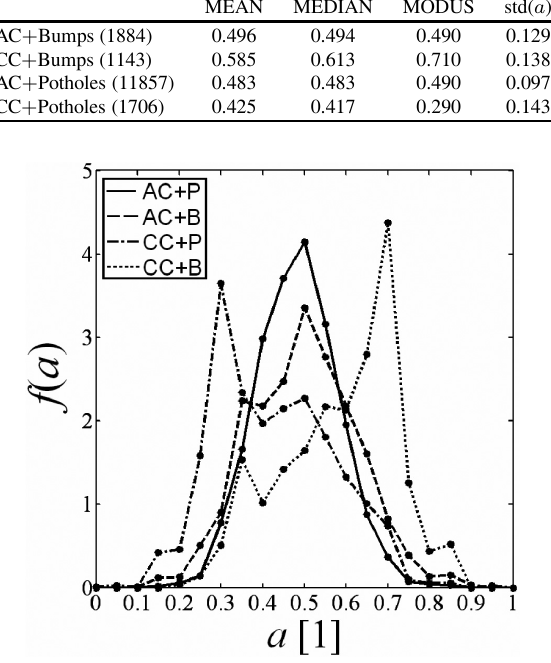
Fig. 5. PDFs of the positions a of extreme values of